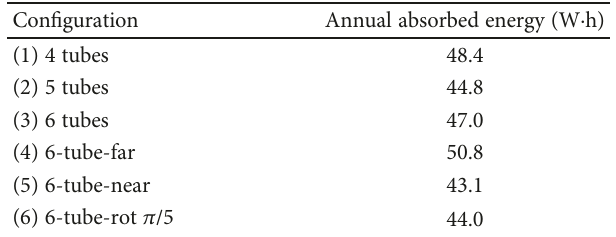
Figure 10: Comparison of energy absorption averaged over the whole year, for each tube of all the con fi gurations. Con fi g: 1 (Figure 9(a)); 2 (Figure 9(b)); 3 (Figure 9(c)); 4 (Figure 9(d)); 5 (Figure 9(e)); 6 (Figure 9(f)). Table 1: Total annual absorbed energy for the di ff erent con fi